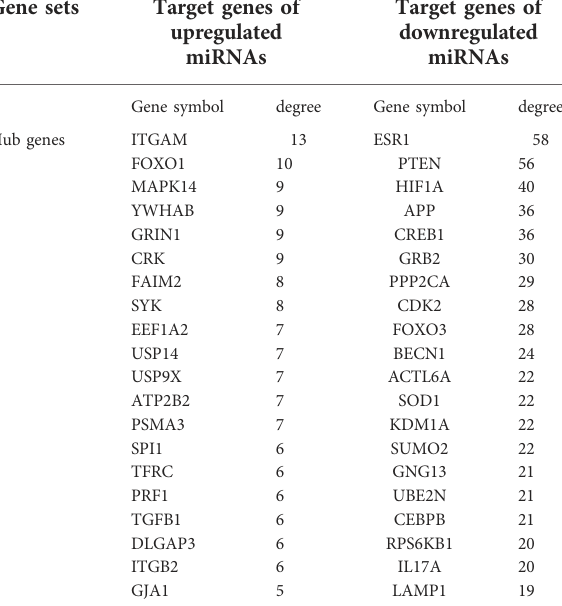
TABLE 2 Go enrichment analysis result of target genes. TABLE 3 the top 20 ranked hub